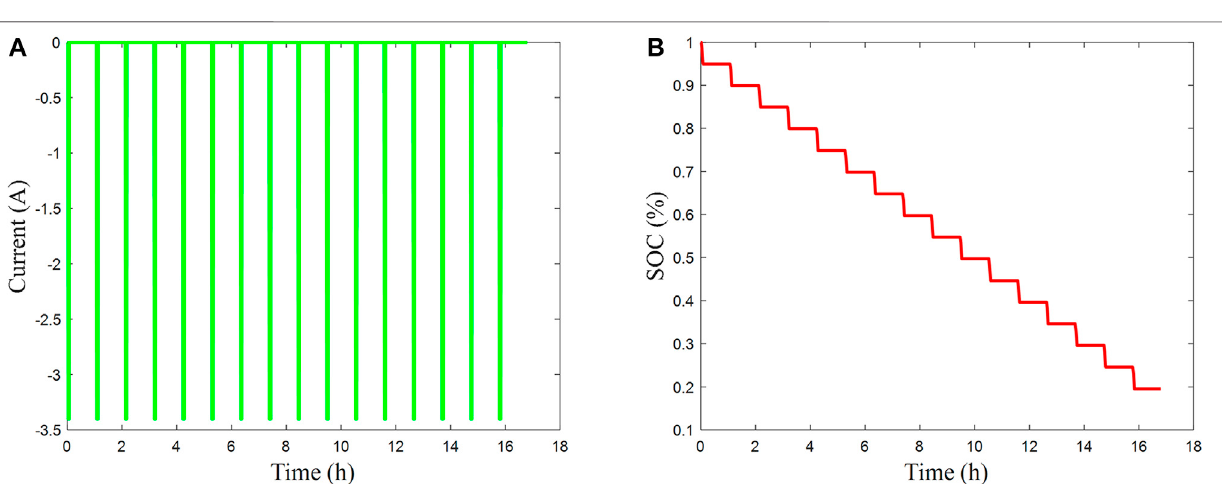
TABLE 3 | Statistical data of identi fi cation methods.